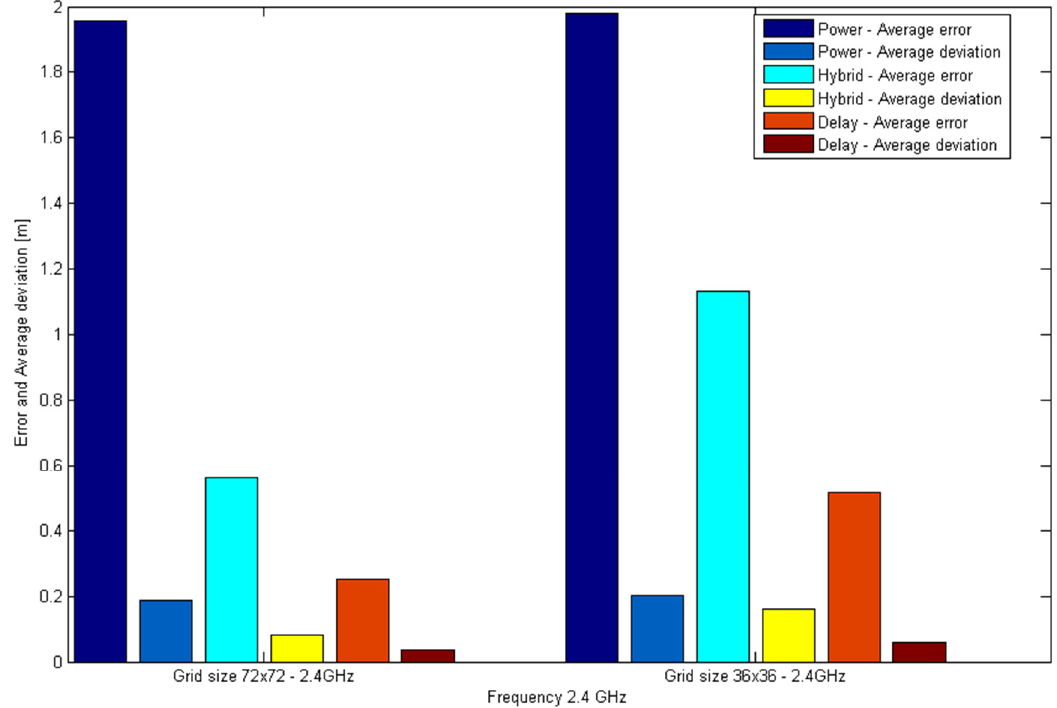
Figure 10. Detection methods comparison: Power, delay and hybrid detection at a frequency of 2.4 GHz.